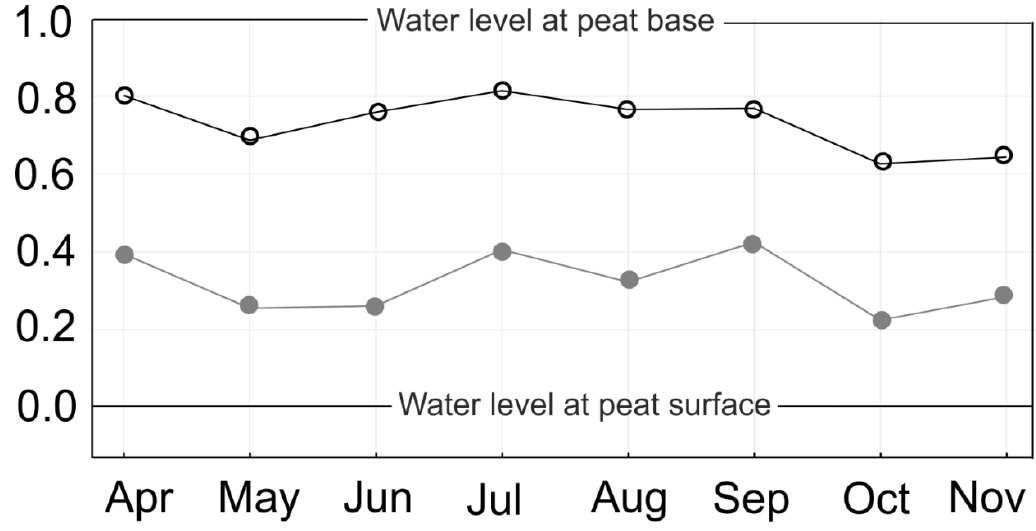
Figure 2. Variation of the water table coefficient (mean water table depth ÷ thickness of residual peat) during the period April to November 2016, for Sector A (unfilled circles) and Sector B (filled circles).